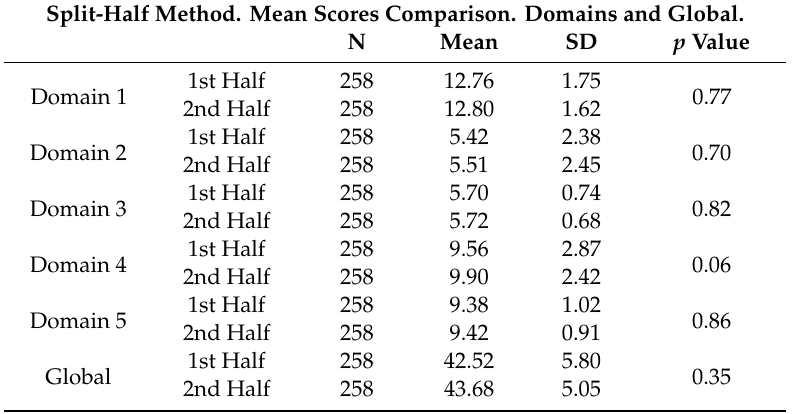
Table 3. Split-half method. Mean score comparison. Domains and global. Split-Half Method. Mean Scores Comparison. Domains and